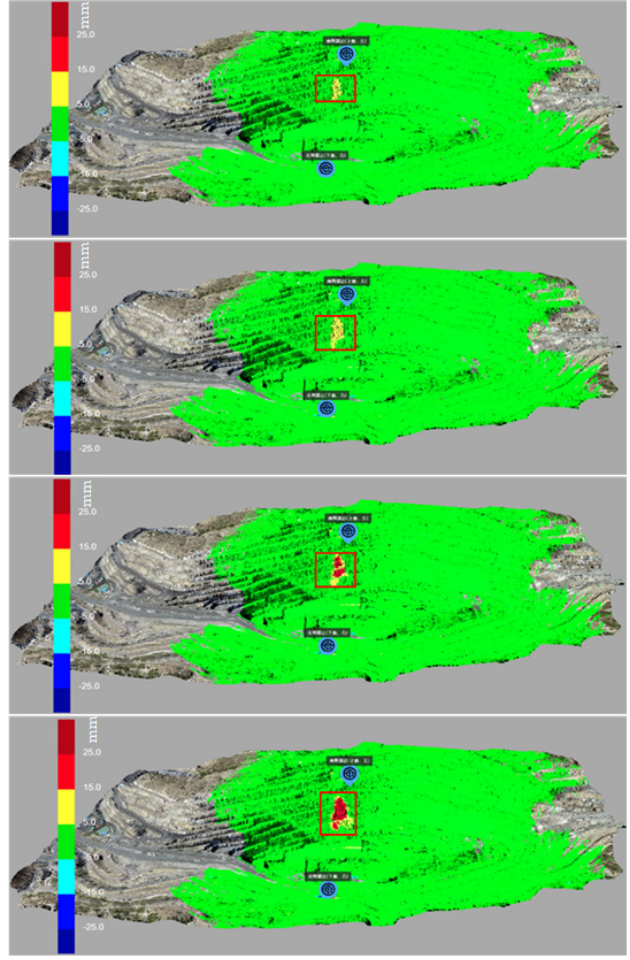
Figure 17. Slope radar monitoring cumulative